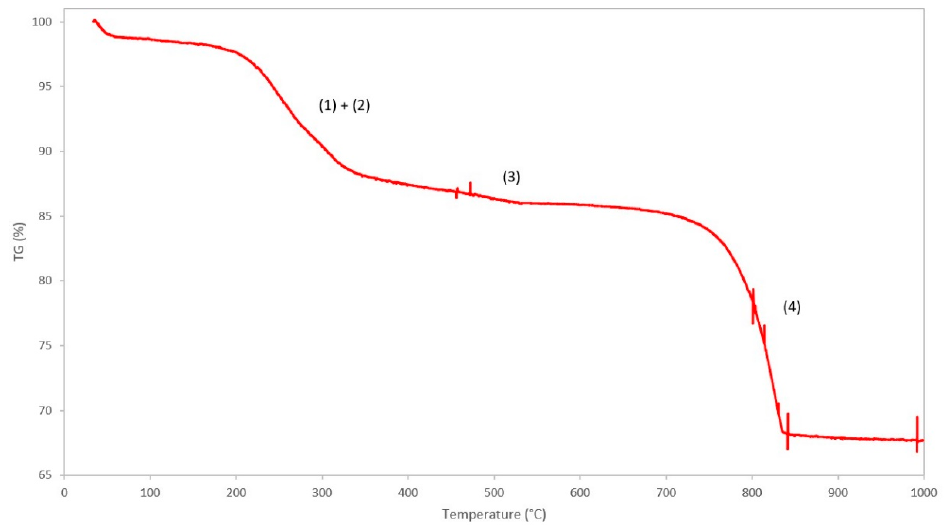
Figure 6. TGA curve of the Ce-LDH and proposed degradation reactions: (1) removal of intramolecular water, (2) dehydroxylation, (3) removal of nitrate groups and (4) removal of sulfate groups.